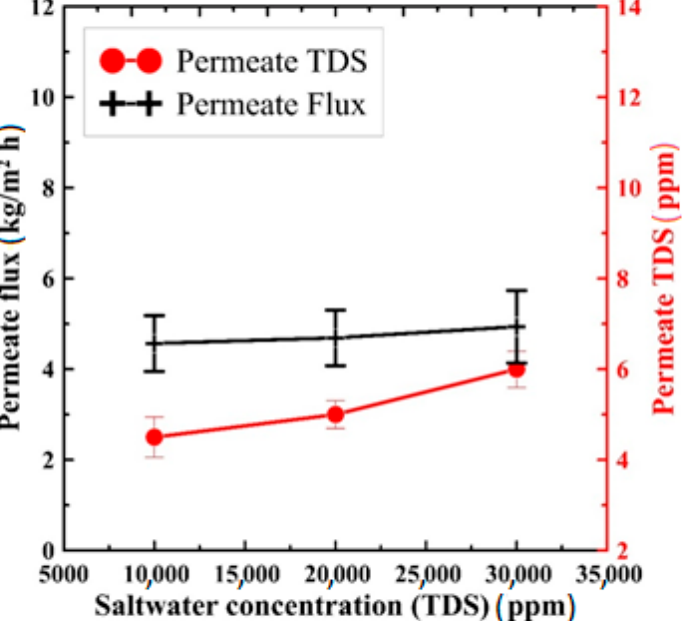
Figure 10. Effect of feed salt concentration on permeate flux and TDS of the produced water at 85 °C saltwater temperature and 100 mL/min rate of flow.